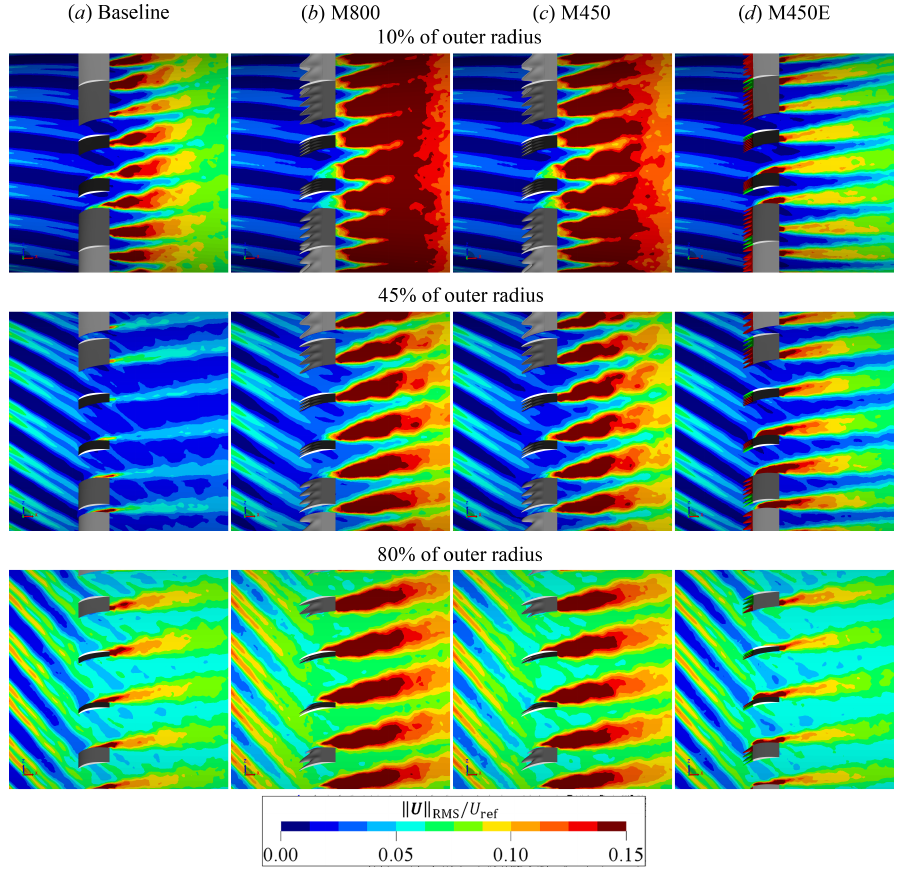
Figure 12. (Side view) Contours of phase-locked standard deviation of velocity magnitude ( || U RMS || ) at the different radial sections ( top —10%, middle —45%, and bottom —80% of the outer radius) in the fan